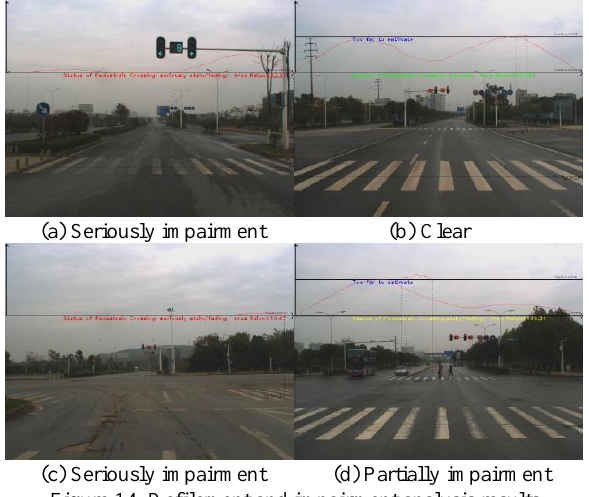
Figure 14. Defilement and impairment analysis results